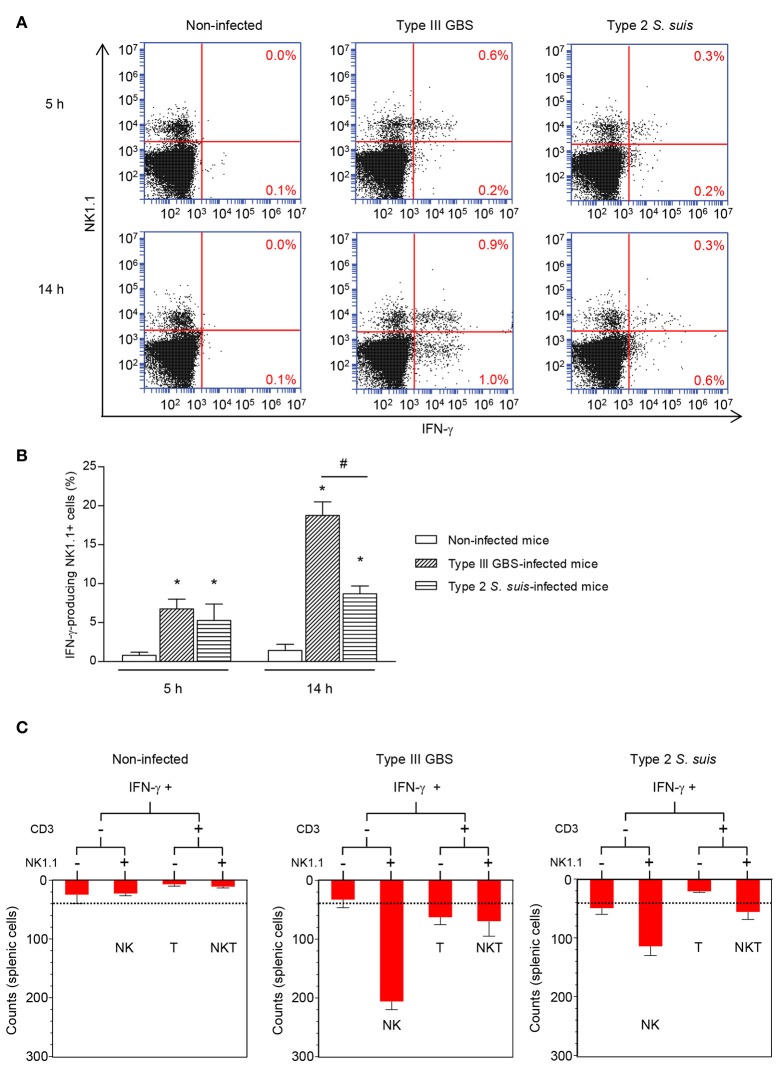
Ex vivo analyses of cellular sources of IFN-γ during the acute phase of streptococcal infections. Mice were infected intraperitoneally with a dose of 1 × 107 of type III GBS wild-type strain COH-1 or 5 × 107 CFU of type 2 S. suis wild-type strain P1/7 (n = 3 per group × 3 individual experimental infections). Spleens were harvested 6 h post-infection and total splenocytes plated at 5 × 106 cells/well. Non-stimulated cells from mock-infected animals served as negative control for basal expression (Non-infected). Total splenocytes were incubated for 5 or 14 h with brefeldin A (3 μg/ml) added during the last 5 h of incubation. Cells were harvested and intracellularly stained for IFN-γ in combination with NK1.1 surface staining (A,B) or in combination with several surface markers for multi-parametric FACS analysis (C). For (B,C), to improve detection, IFN-γ expression was analyzed on 10,000 NK1.1+
(B) or 5,000 NK1.1+
(C) gated cells and data expressed as means ± SEM from three different experimental infections. *P < 0.05, indicates statistically significant difference compared to non-infected control mice. #P < 0.05, indicates statistically significant difference between type III GBS- and type 2 S. suis-infected mice. For (C), results show IFN-γ+ cells within different spleen cell populations at 5 h. Dot-line indicates an increase in IFN-γ production over non-infected controls.